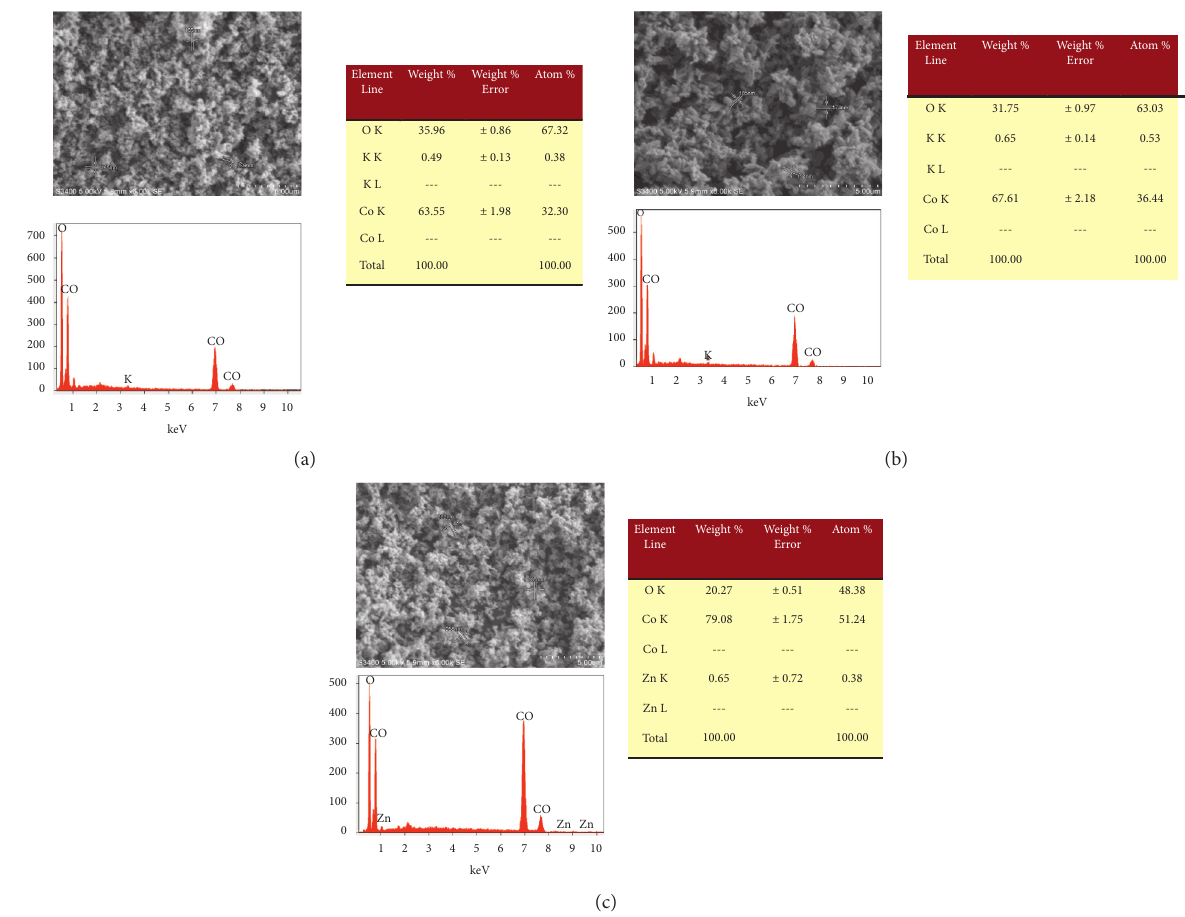
Figure 3: SEM images of Solanum tuberosum leaf templated formed Co corresponding